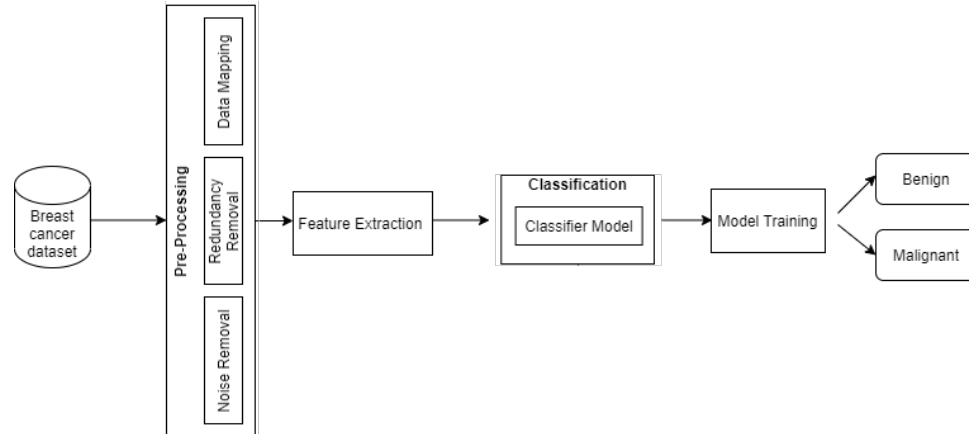
Figure 2. Proposed breast cancer classification